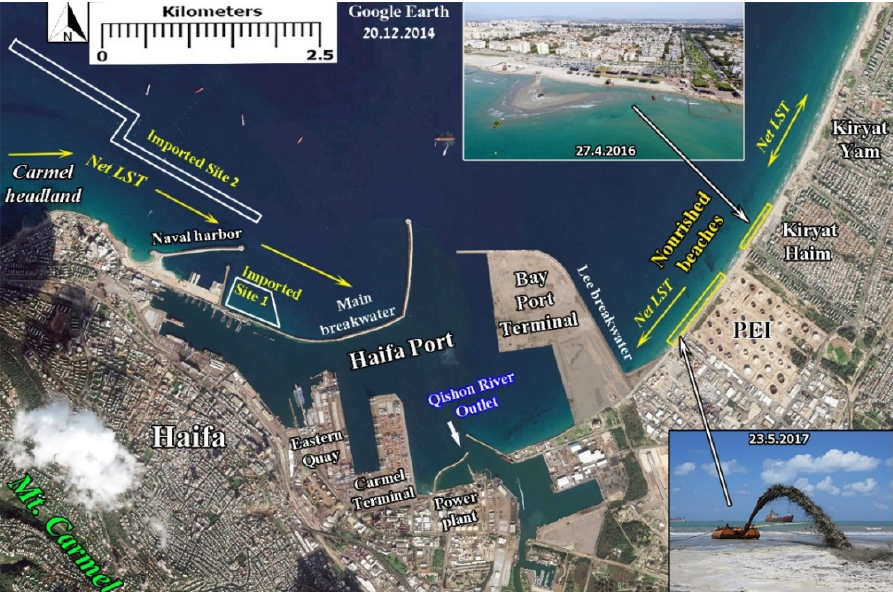
Figure 3. South Haifa Bay sand beach nourishment projects (May 2016–June 2017). Aerial photograph of Kiryat Haim bathing beach (Yehudit Naot Beach) during the first nourishment operation (top inset). Nourishment rainbowing operation via discharge pipe south of Petroleum and Energy Infrastructure Ltd. (PEI) (23 May 2017) (bottom inset). Background: Google Earth image, 20 December 2014 ( after [39]) .